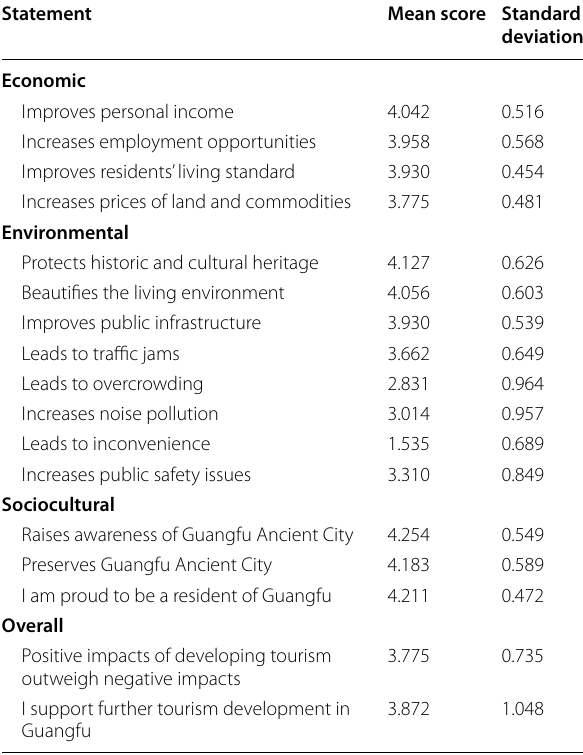
Table 6 Residents’ perceptions of the impacts of tourism